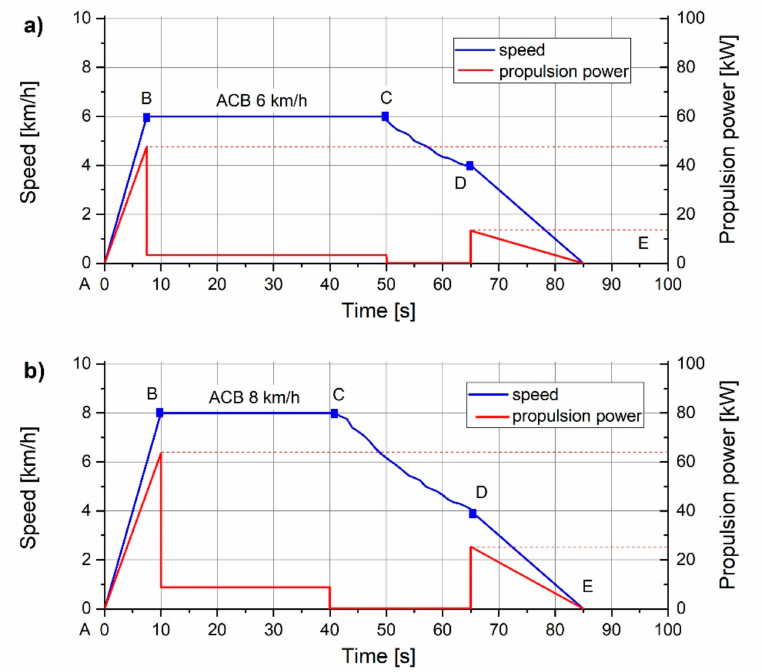
Figure 7. Ship speed and power demand for the ACB strategy: ( a ) Maximum speed of 6 km / h, ( b ) maximum speed of 8 km / h; A—start, B—end of the acceleration stage, C—propulsion turned o ff , D—start of braking, E—stopping of the